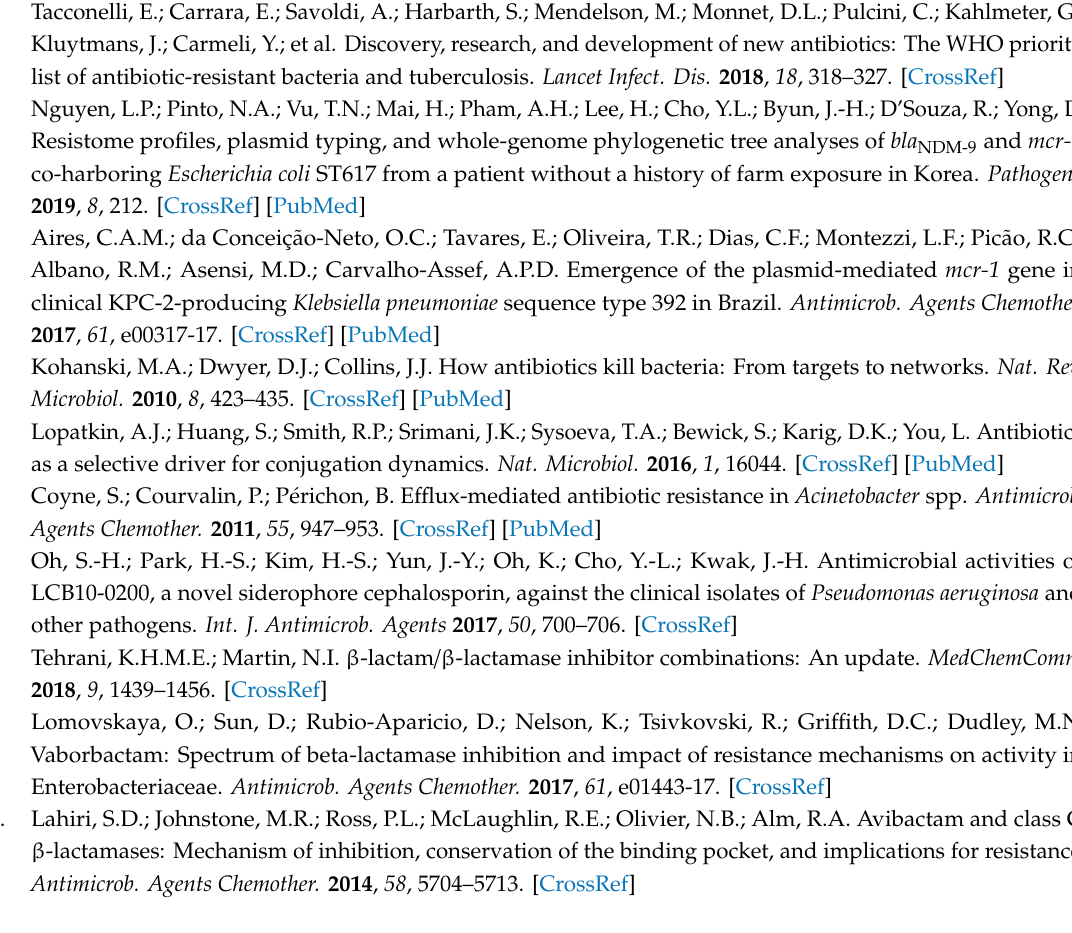
Table S1: List of primers for cloning experiments, Table S2: GenBank accession numbers and reference gene loci used for alignment to siderophore uptake